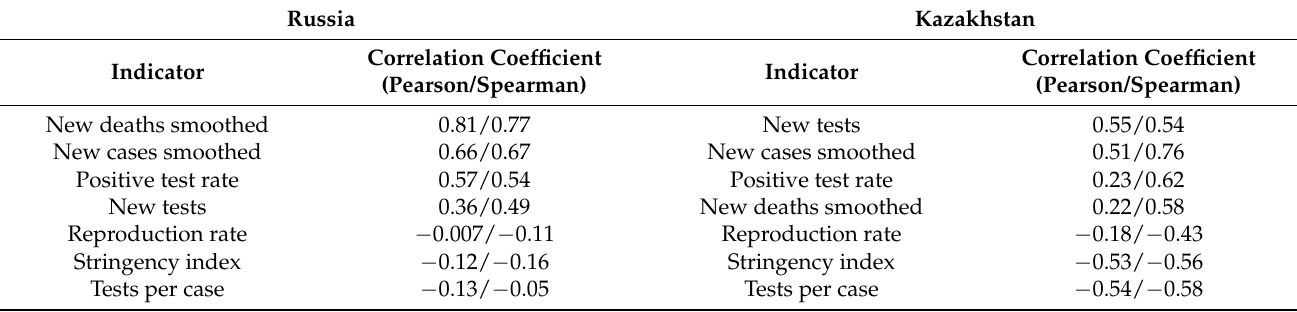
Table 5. Correlation between average sentiment and COVID-19 indicators.